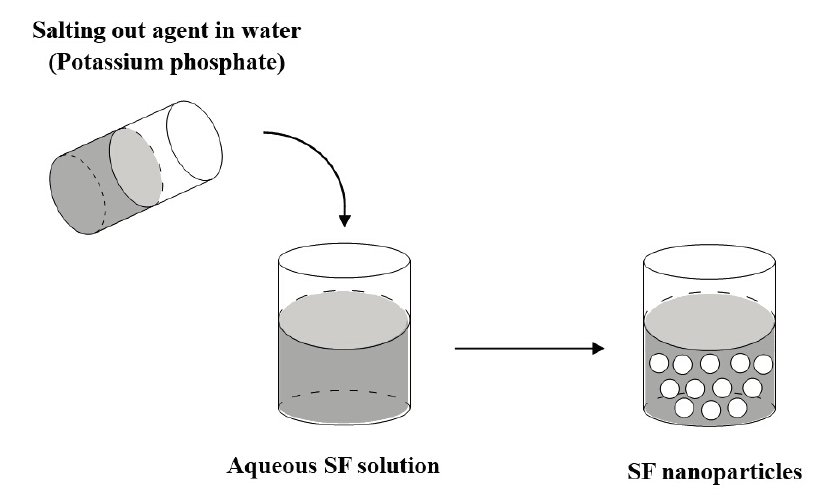
Figure 2. Schematic diagram of the salting out method for preparing SF